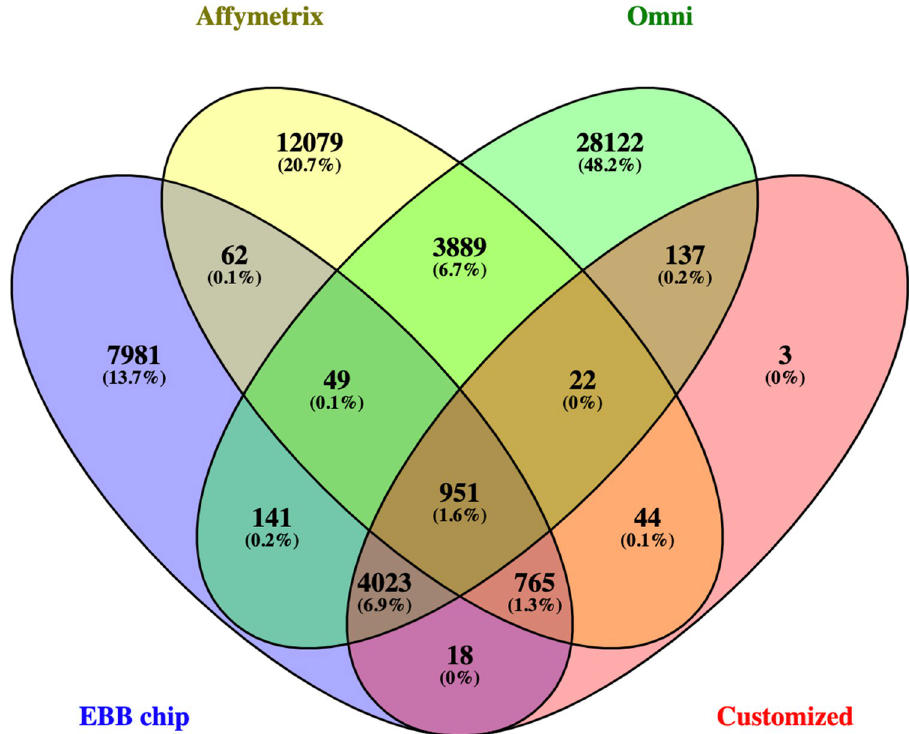
Fig 3. Number of shared variants between datasets. Variants in common between the different chips on chromosome 20.